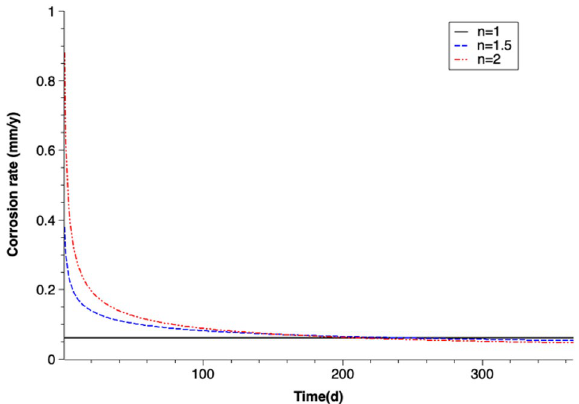
Figure 3. Corrosion rates versus time (n is the coefficient of passivation) assuming goethite is the corrosion product.